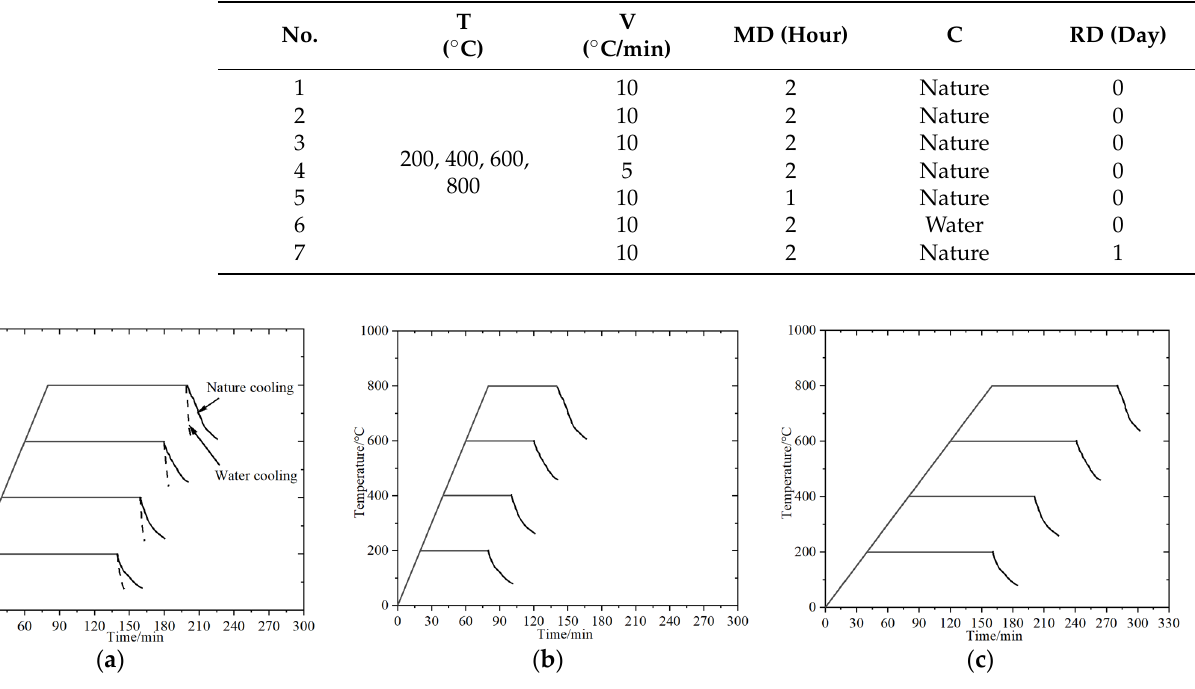
Figure 5. High temperature operating mechanisms. ( a ) 10 °C/min-2 h. ( b ) 10 °C/min-1 h. ( c ) 5 °C/min-2 h. Table 3. Mix proportions of concrete specimens (kg/m 3 ).